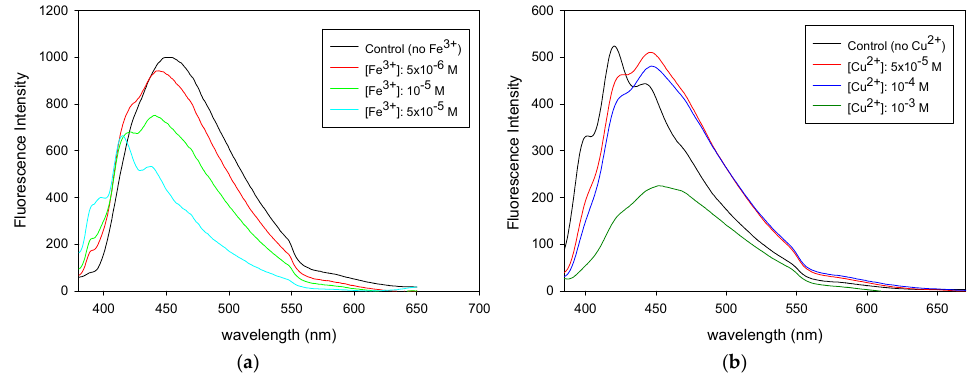
Figure 5. Fluorescence spectra of the methanol-swollen networks samples after being exposed to methanol solutions of various metal ion concentrations: ( a ) Fe 3+ fluorescence monitoring; ( b ) Cu 2+ monitoring.